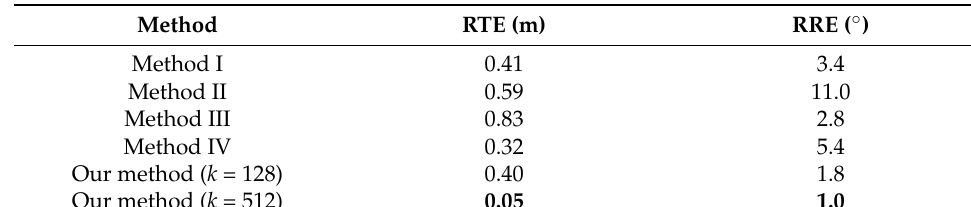
Table 3. Registration results of each method from scan #34 to scan #33 in Dataset I.